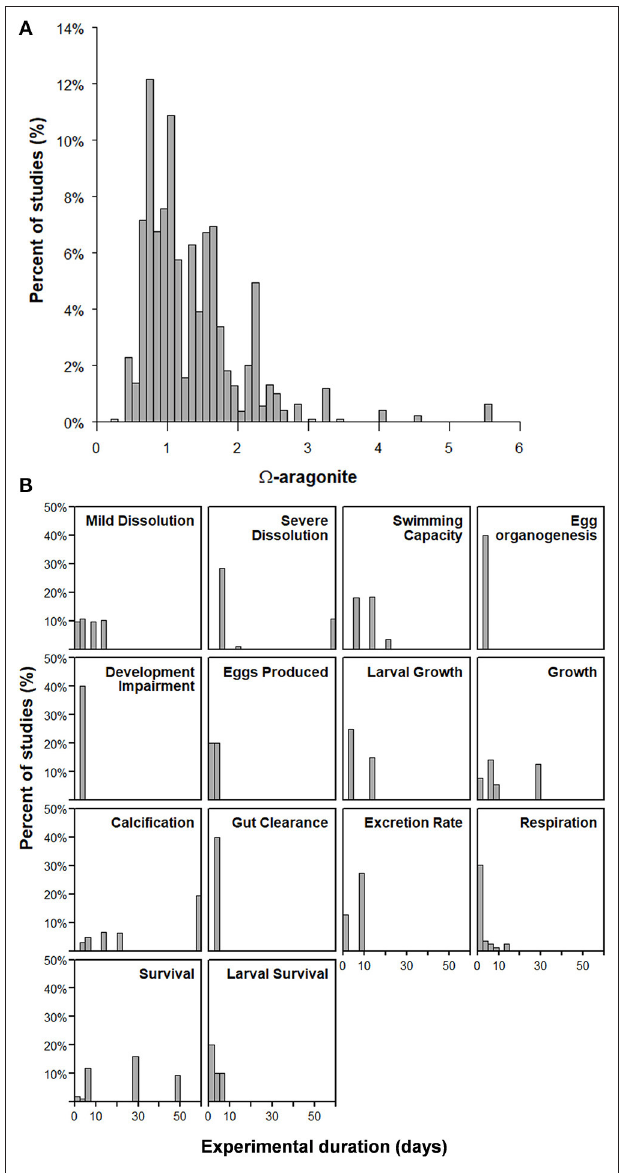
FIGURE 2 | (A) Summary of experimental studies with respect to the (cid:127) ar conditions and (B) the duration of experimental exposure used in treatments.